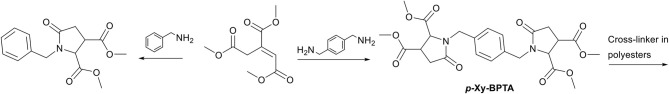
Schematic overview of model aza-Michael addition reaction on trans-trimethyl aconitate as presented in this work.